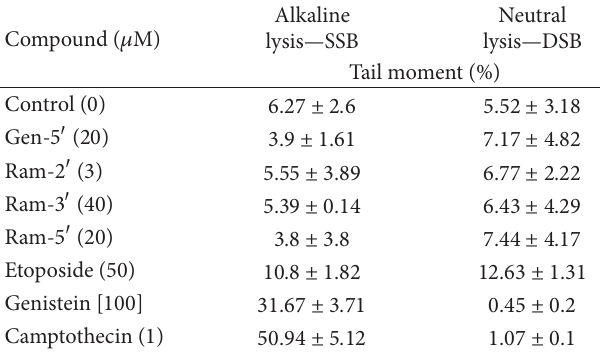
Table 2: Single-strand breaks (SSB) and double-strand breaks (DSB) detected with comet assays in HCT 116